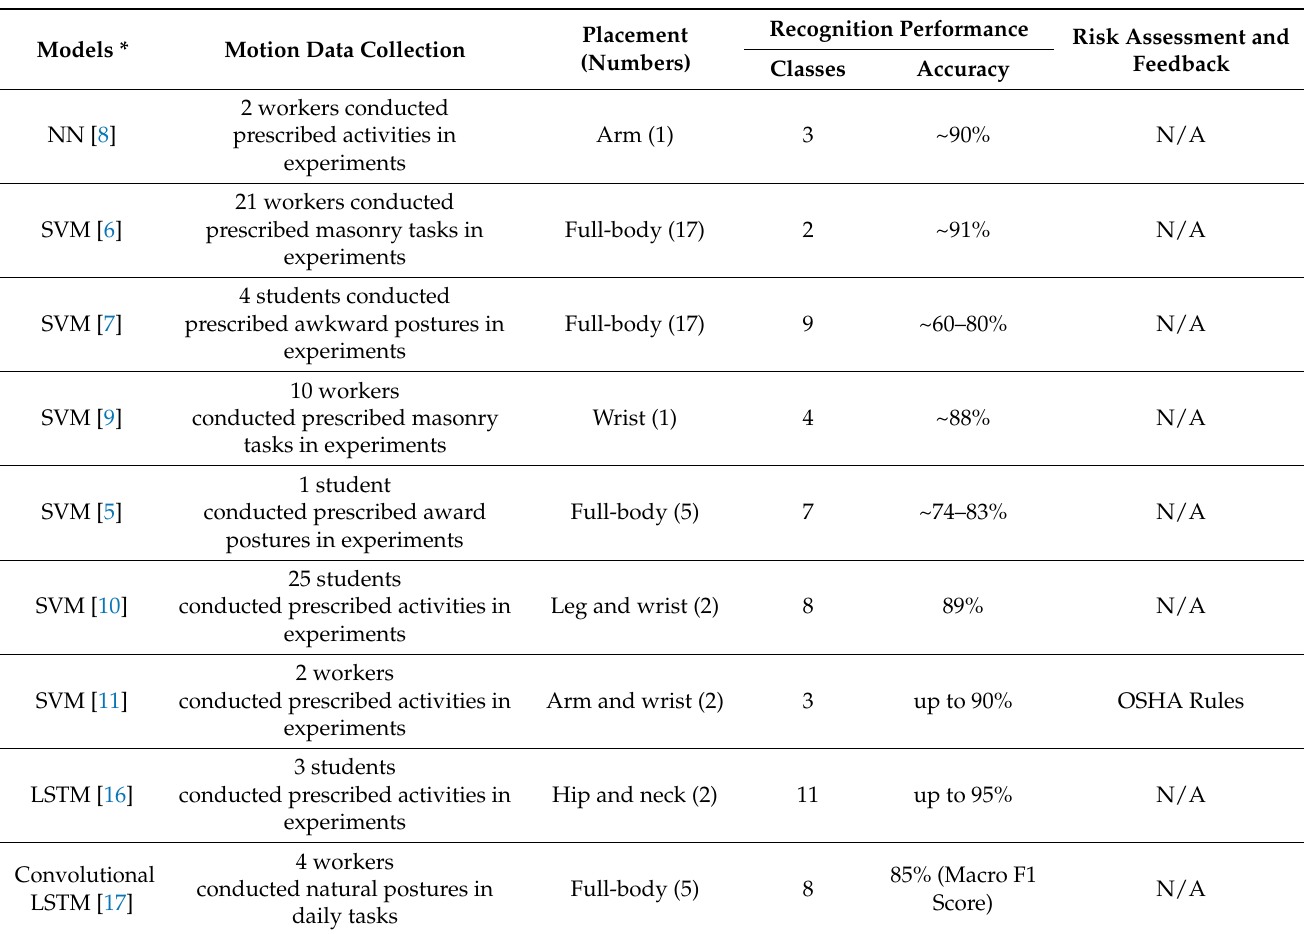
Table 1. Review of related studies applying machine learning (ML)-based models for inertial measurement unit (IMU) output in construction.